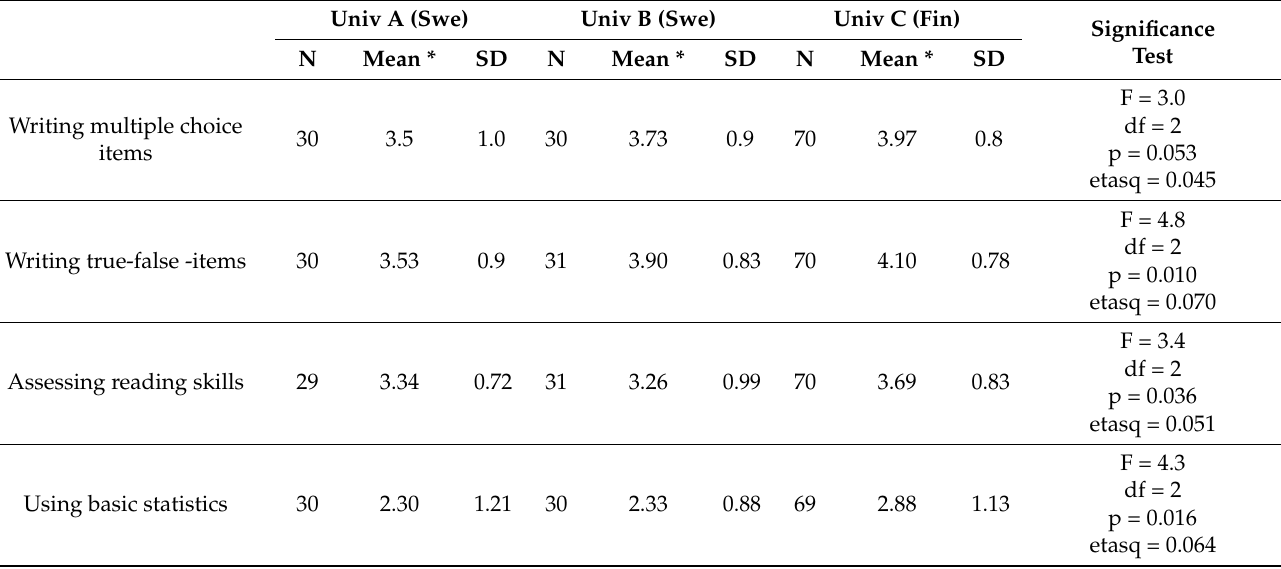
Table 7. Pre-service teachers’ perceived competence in summative assessment practices by university. Univ A (Swe) Univ B (Swe) Univ C (Fin)